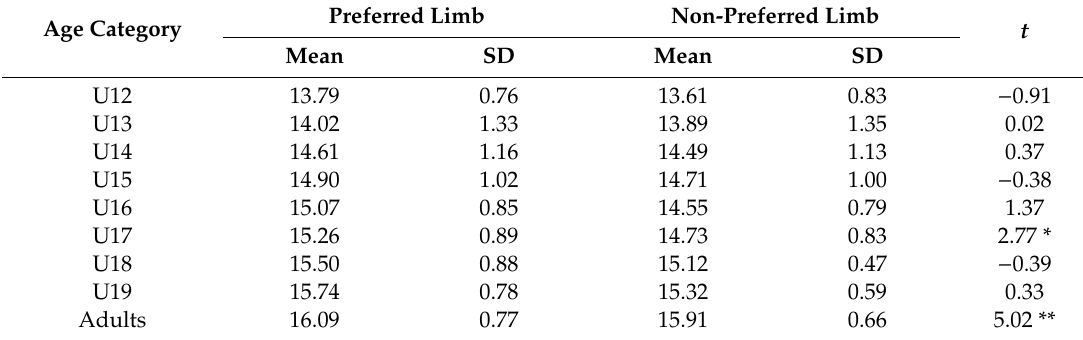
Table 4. The e ff ect of age on inter-limb